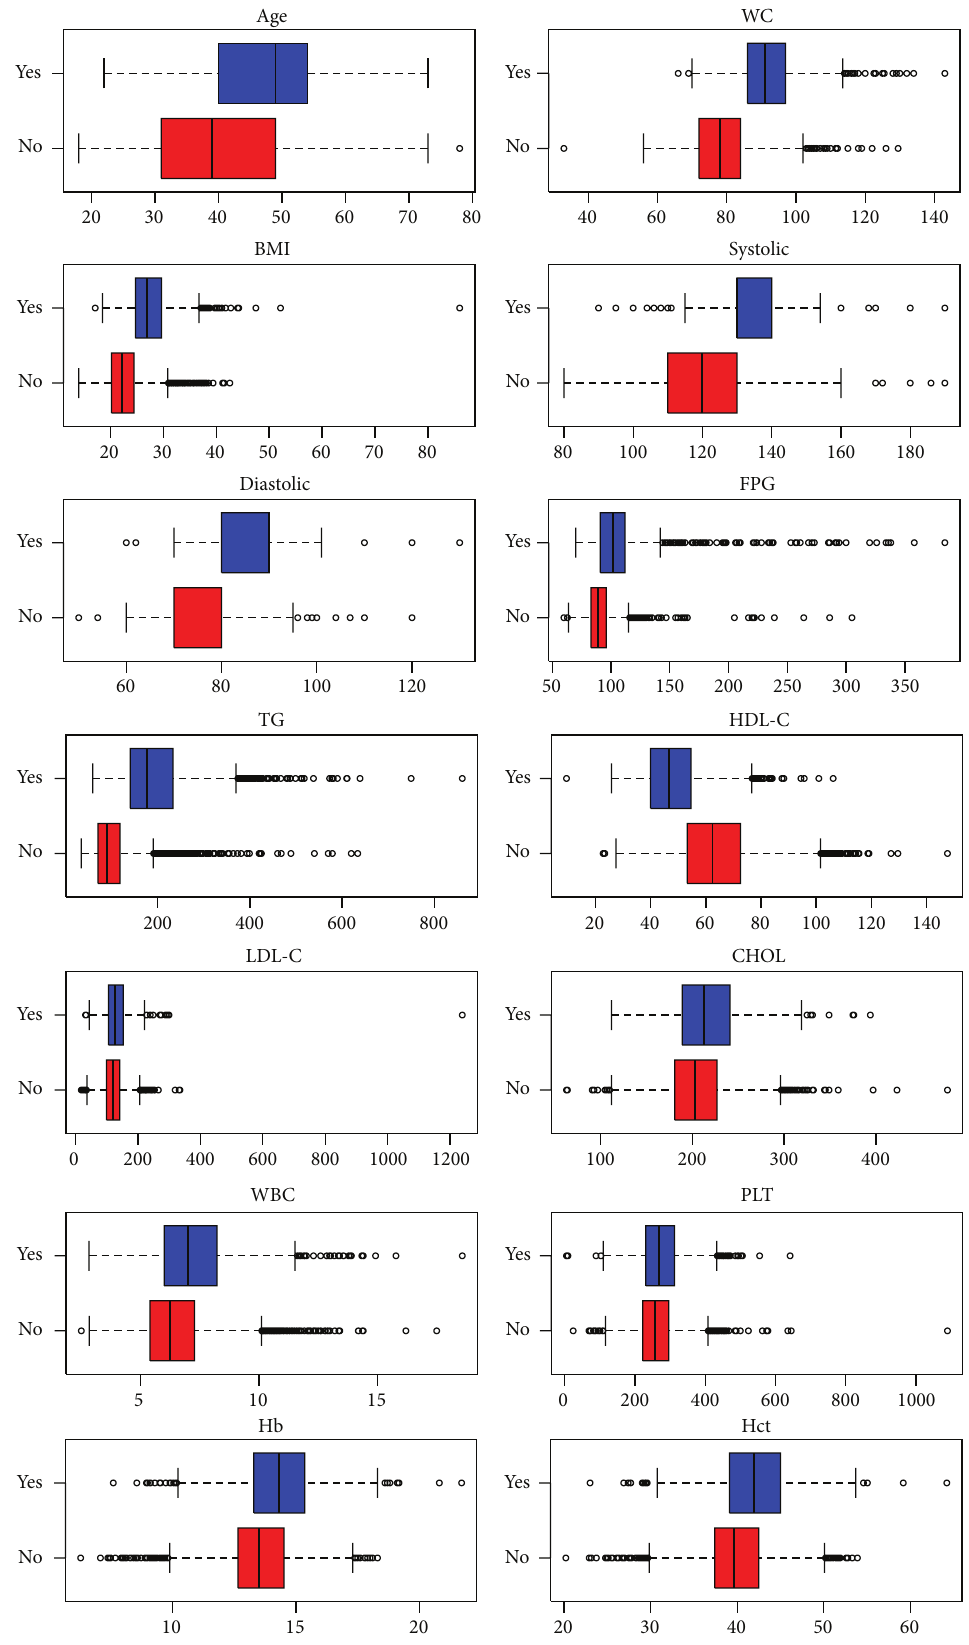
Figure 2: Box plots of biochemical parameters of metabolic syndrome (Yes) and nonmetabolic syndrome (No)